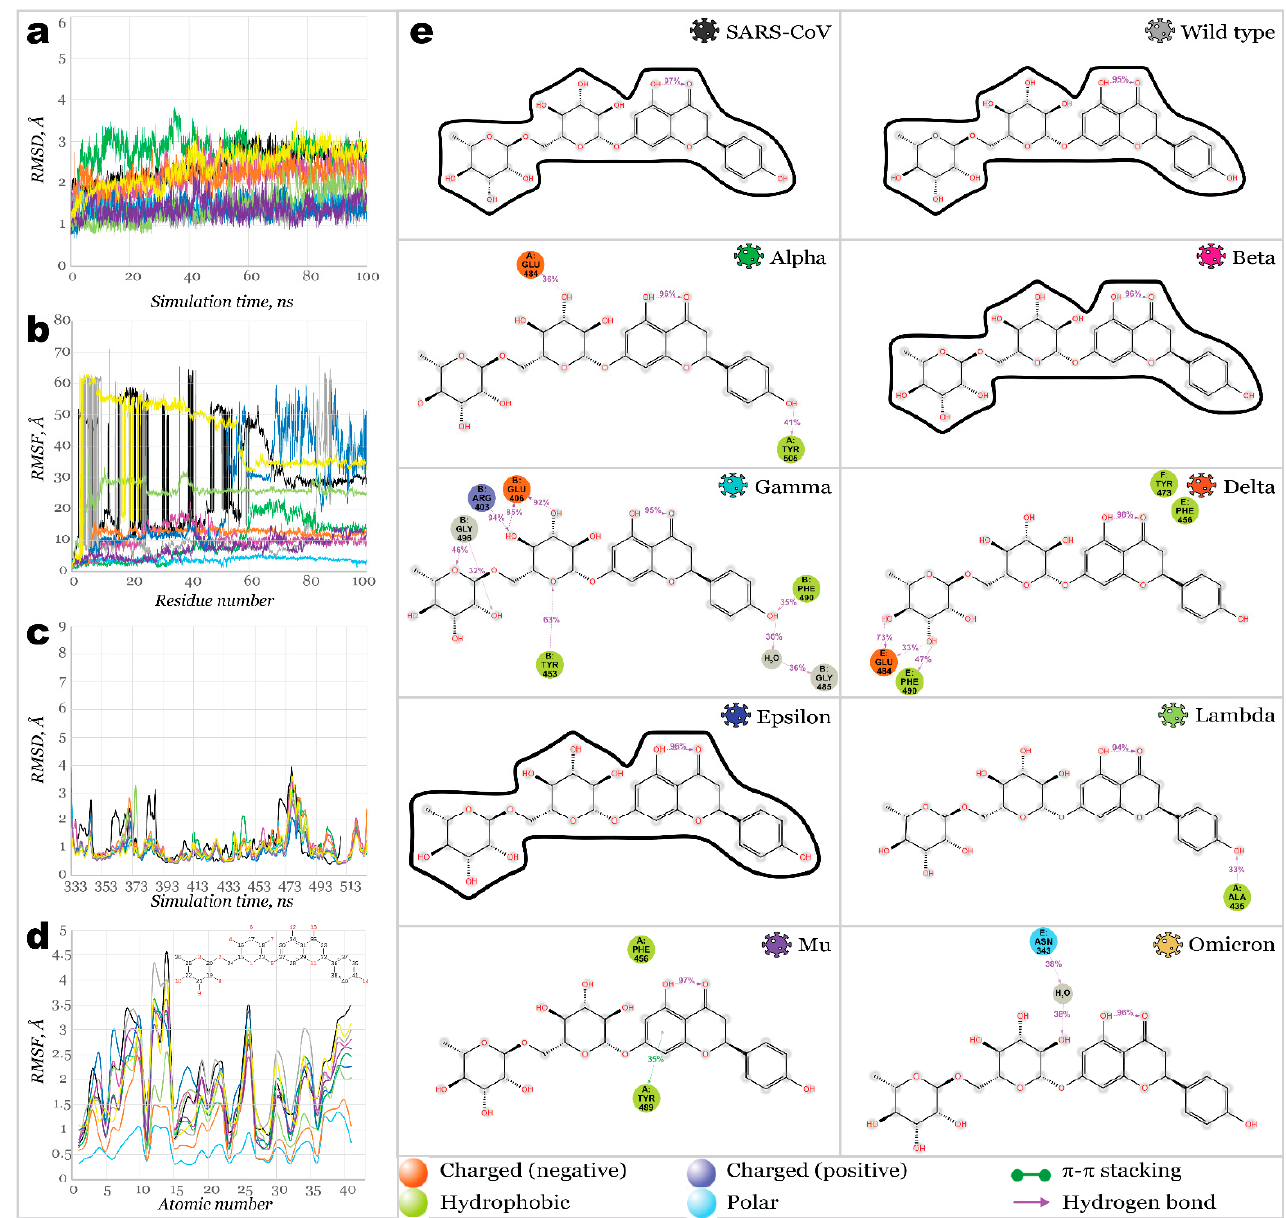
Figure 8. 100 ns MD simulations results for RBD 38 (narirutin) complexes: ( a )—RMSD of protein’s Ca ; ( b )—RMSF of protein structures; ( c )—RMSD of ligand fit on protein; ( d )—RMSF of ligand’s structures; ( e )—2D interactions diagram for narirutin and RBDs.